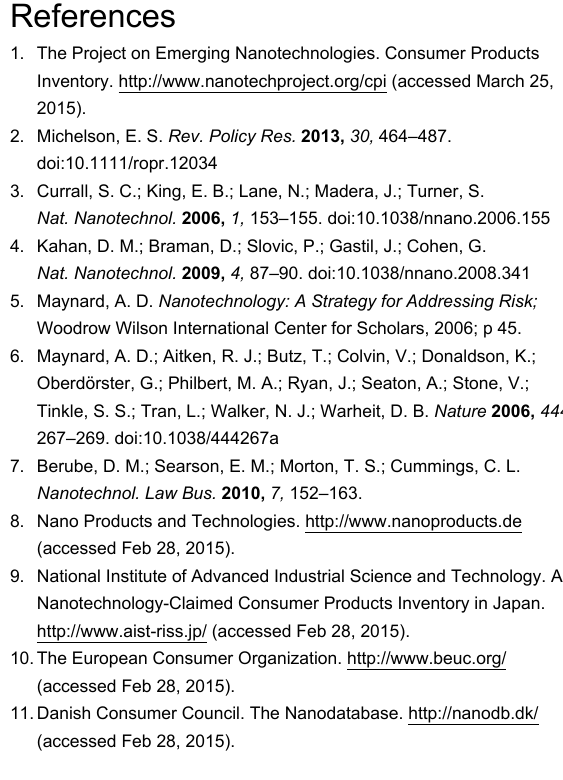
Third-party Compelling information Manufacturer claims to Manufacturer provides information is from multiple use nanotechnology supporting information available